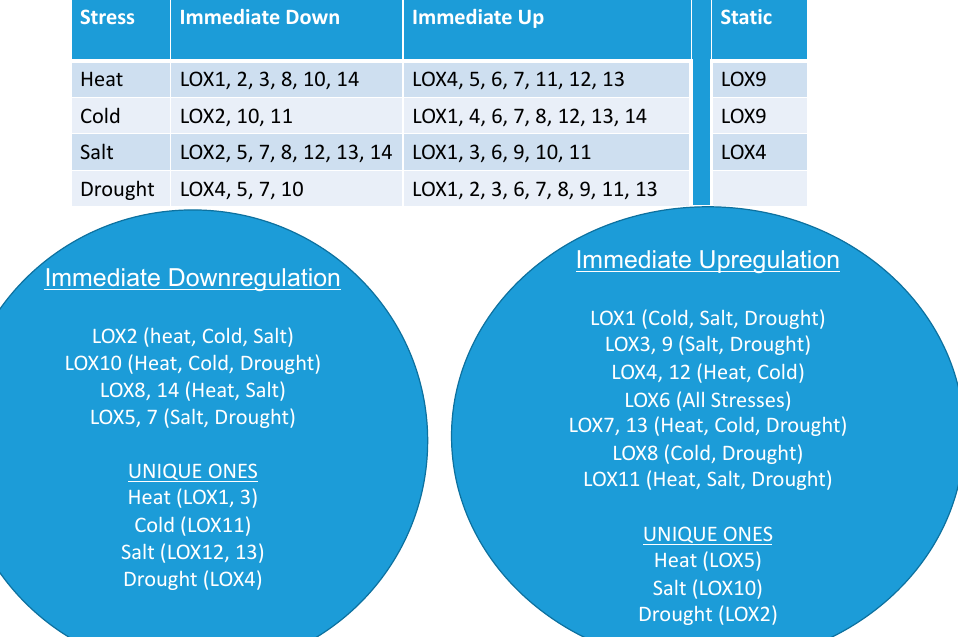
Figure 7. Summary of the immediately downregulated, immediately upregulated and non-responsive (static) tomato 9-LOXs and 13-LOXs genes in response to the four different and independently applied abiotic stresses.